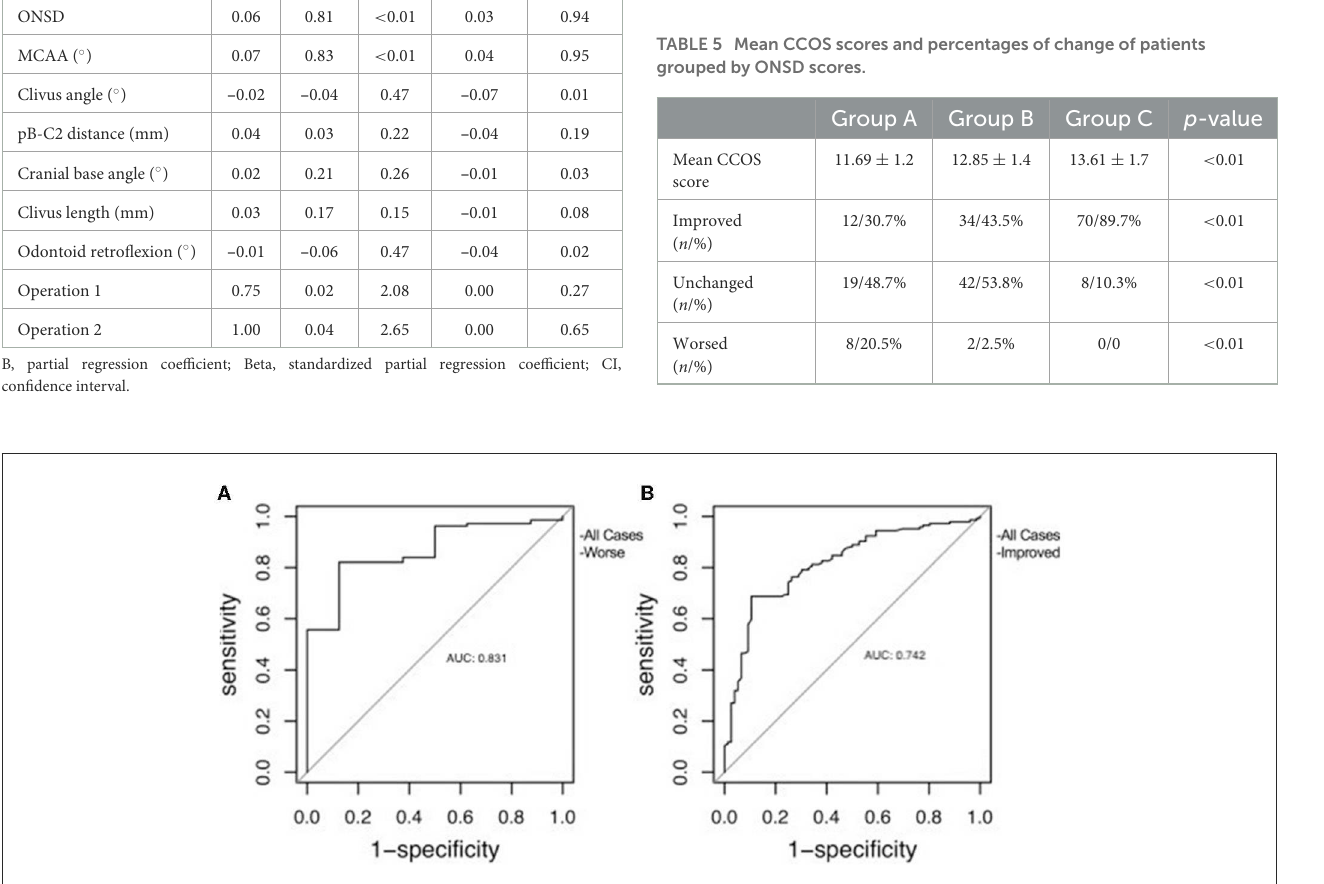
FIGURE2 The receiver operating characteristic curve of ONSD used to predict clinical outcome. (A) Correlation with clinical worsening. (B) Correlation with clinical